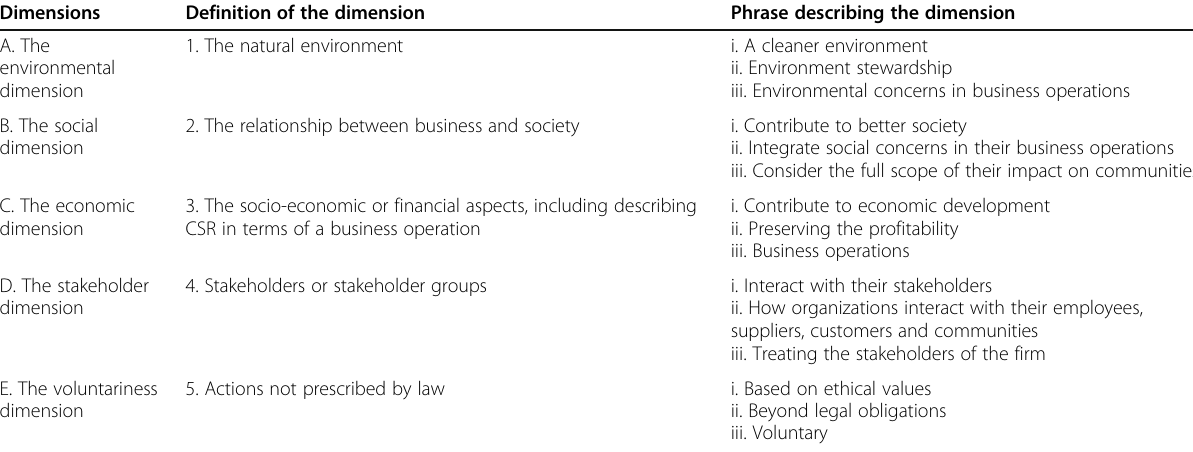
Table 2 Five dimensions of corporate social responsibility Dimensions Definition of the